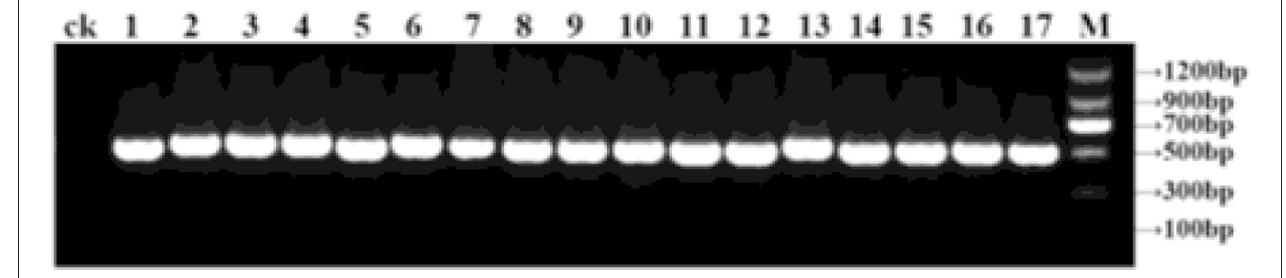
FIGURE 1 | PCR amplification of rDNA-internal transcribed spacer (ITS) from part of isolates. M: Marker; 1-17: bacterial strain XB4, XB7, XB52, X7, YL26, XB34, TH002, HR002, HL23, R13, KD018, X5, XB050, XB007, XB042, XB049, and XB05; ck: ddH 2 O.